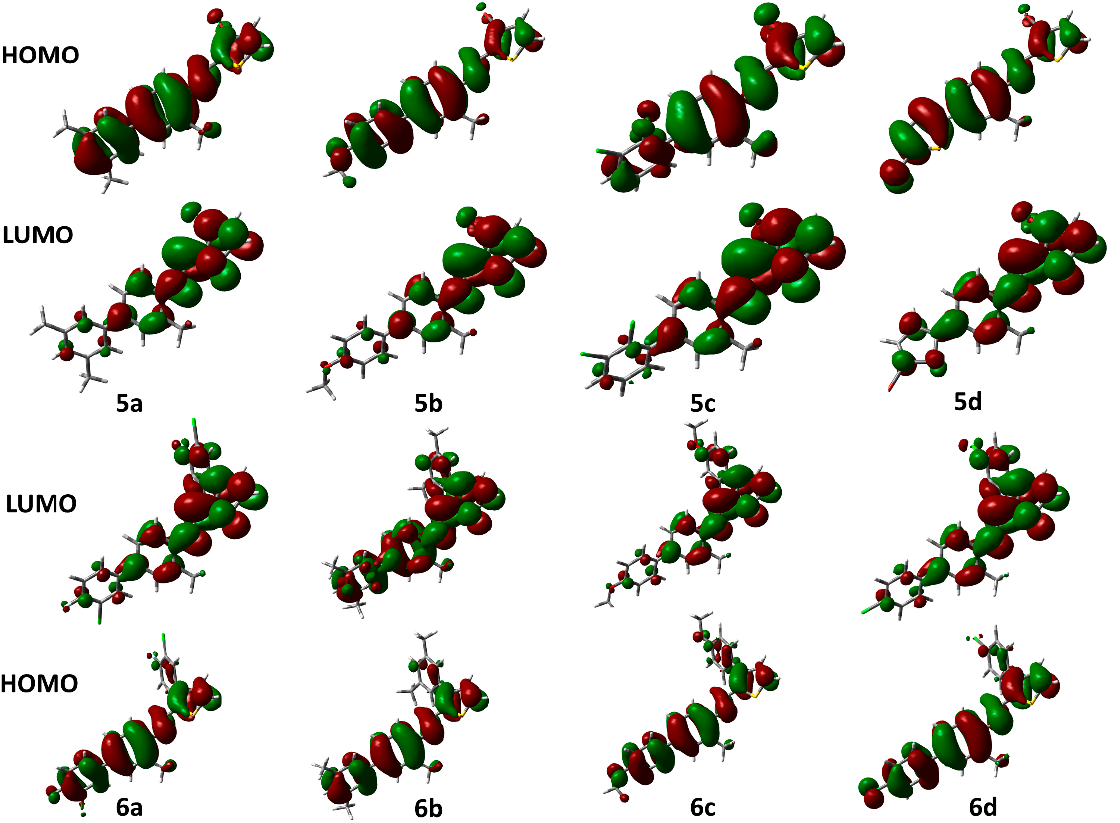
Figure 3. A presentation of the frontier orbitals of various synthesized analogues ( 5a – 5d, 6a – 6d ) calculated at PBE0 D3BJ/def2-TZVP/SMD 1,4-Dioxane level of theory.